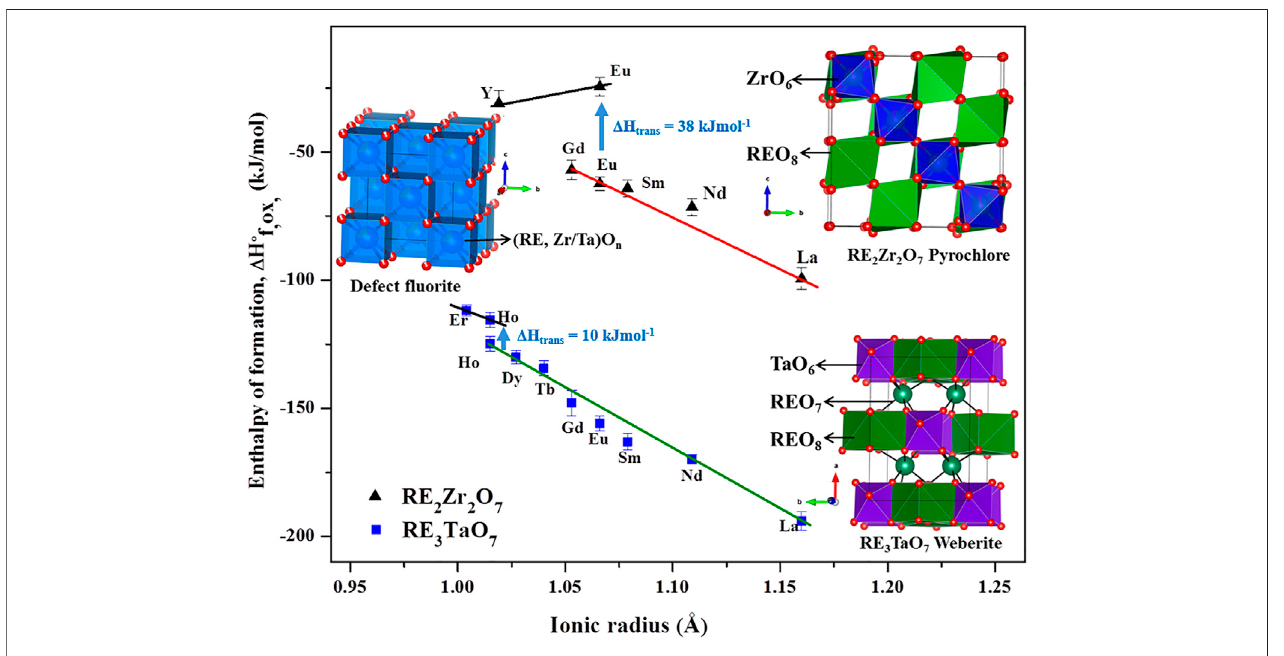
FIGURE 1 | Structure and energetics of order-disorder transitions between ordered pyrochlore, weberite, and disordered defect fl uorite structures with RE 2 Zr 2 O 7 and RE 3 TaO 7 systems as examples. The fi gure has been made based on data from the literature (Saradhi et al., 2012; Subramani and Navrotsky, 2019).